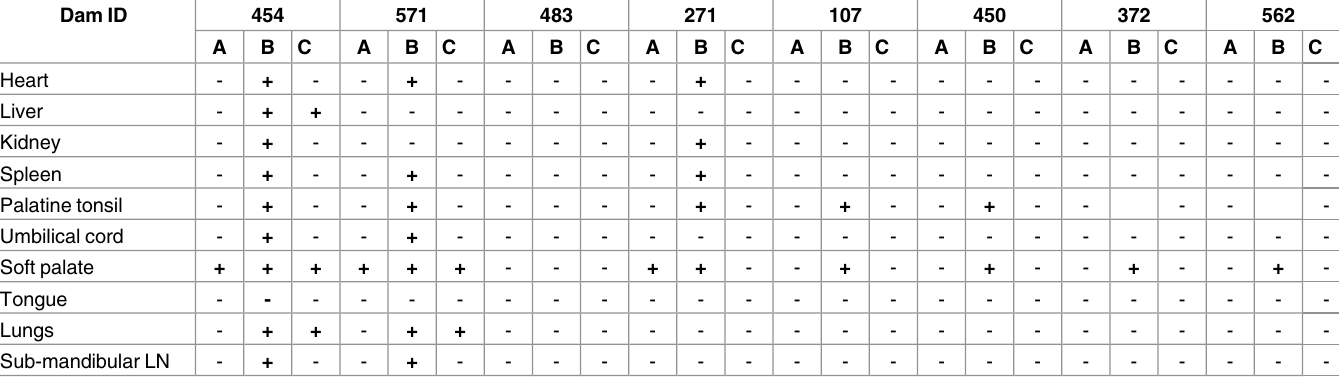
Table 2. FMD detection in tissues collected form aborted fetuses and dead